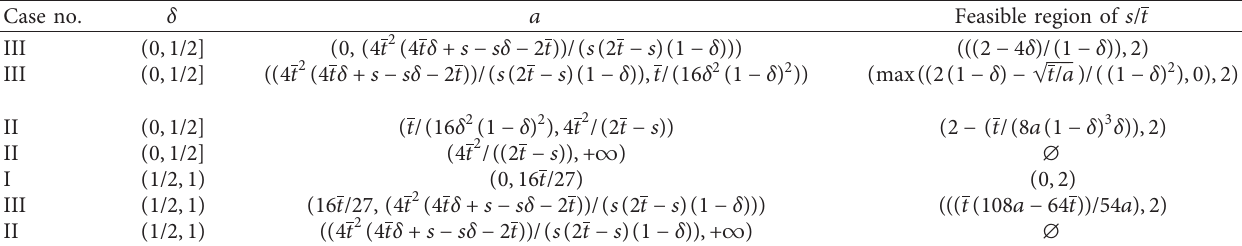
Table 6: The feasible regions of s / t where the retailer should offer BOPS. Case no.